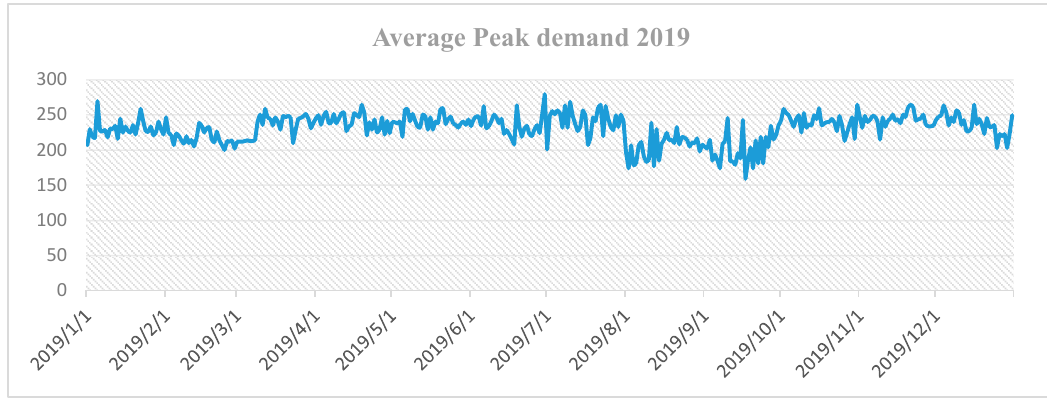
Figure 8. Simulated average peak demand for the year 2019.